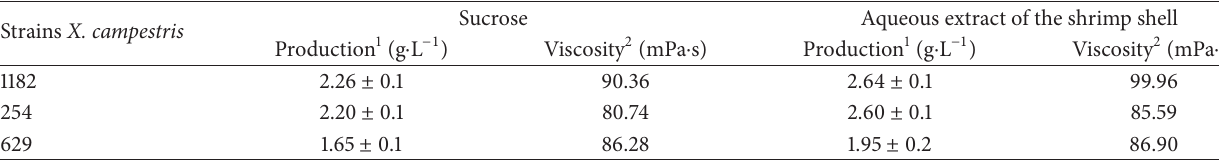
Table 4: Production of xanthan gum from sucrose and from the aqueous extract of the shrimp shell by Xanthomonas campestris strains and the viscosity of the aqueous xanthan gum solutions.